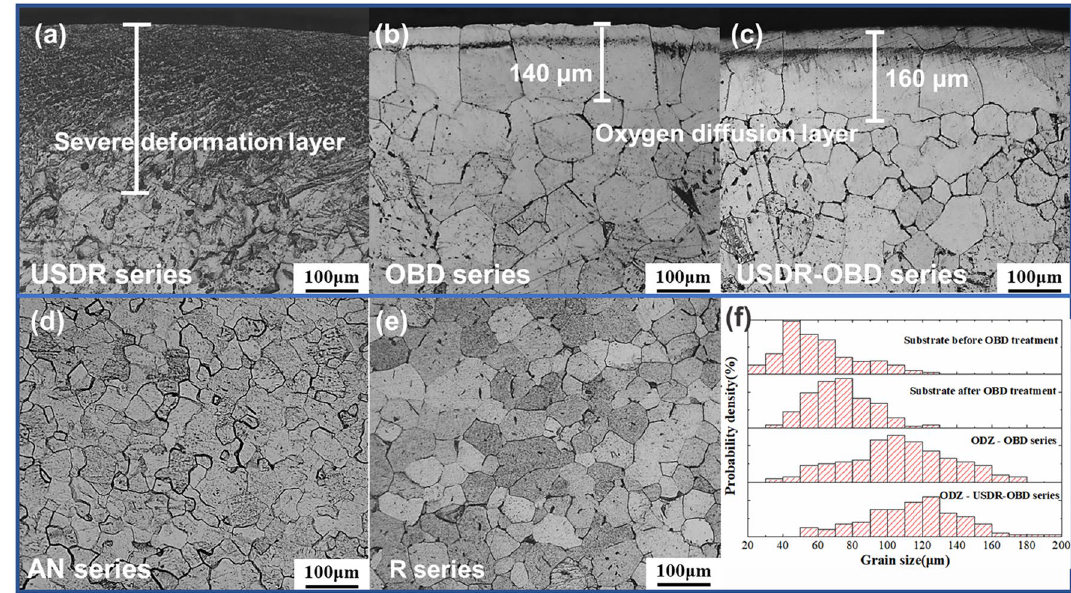
Figure 4. Microstructure from the cross section of ( a ) USDR series, ( b ) OBD series and ( c ) USDR-OBD series; microstructure from the substrate of ( d ) AN series, ( e ) R series; and ( f ) distribution of grain size in substrate and ODZ of different